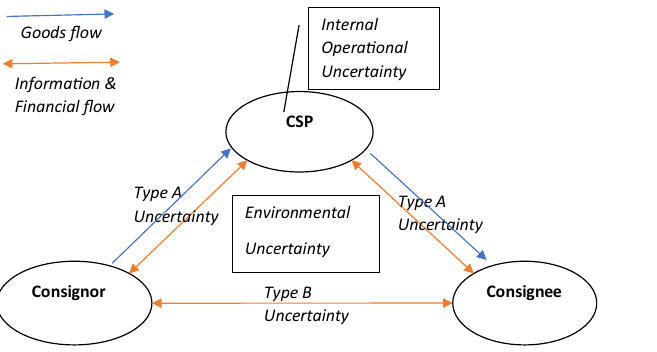
Figure 3. A triadic model of